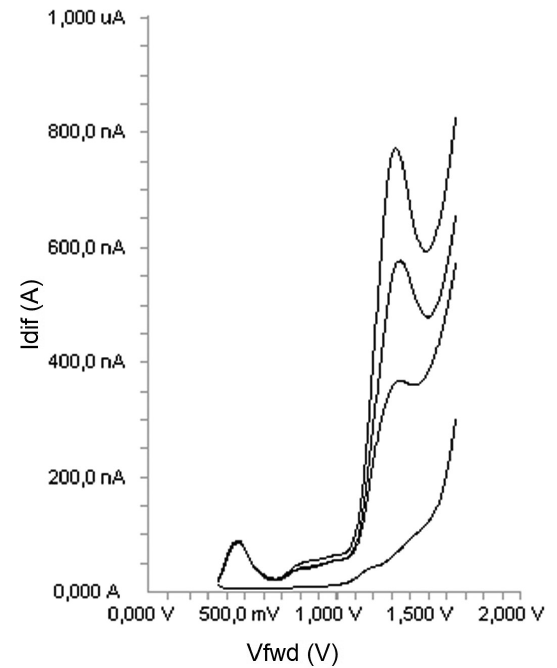
FIGURE 6 - DPV voltammograms obtained for the determination in spiked serum (blank, 5, 10 and 15 µ g mL -1